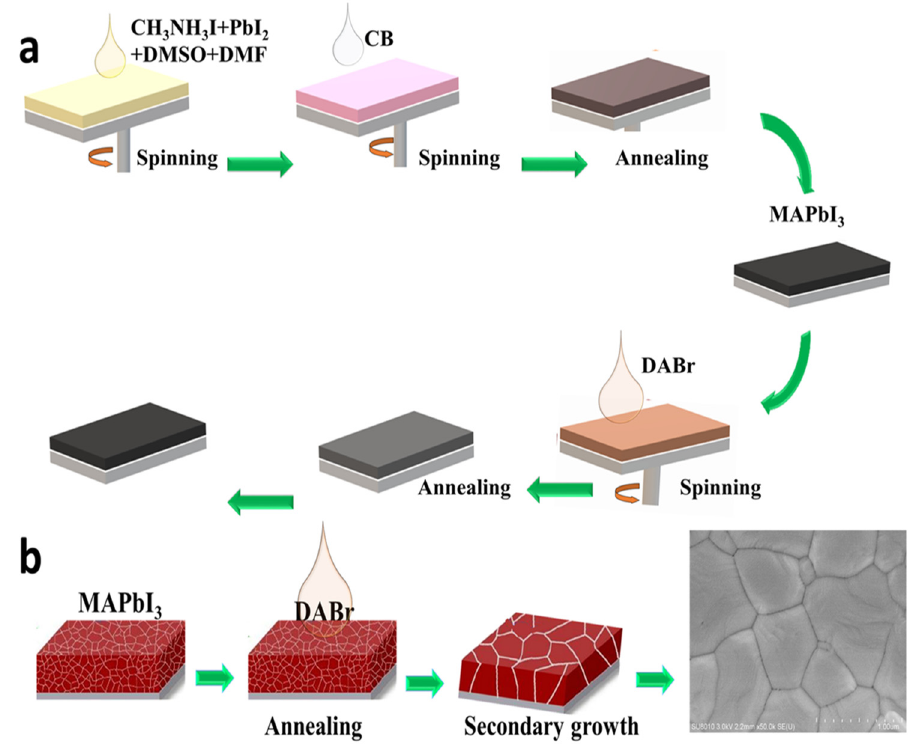
Figure 1. ( a ) Illustration for the fabrication of DABr capped 3D MAPbI 3 film via DABr surface treatment method, ( b ) pictorial presentation of DABr capped MAPbI 3 film evolution via DABr surface treatment method.